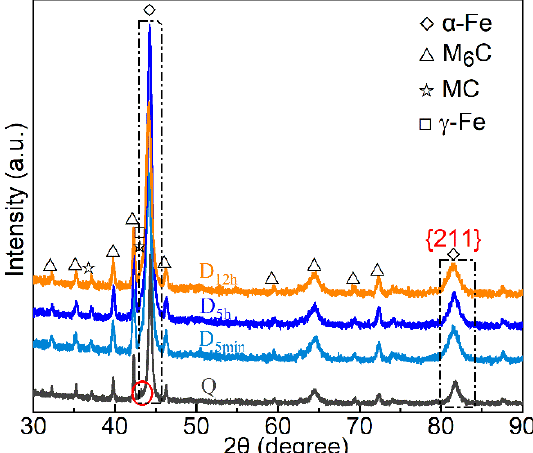
Figure 3. XRD pattern of Q, D 5min, D 5h , and D 12h .